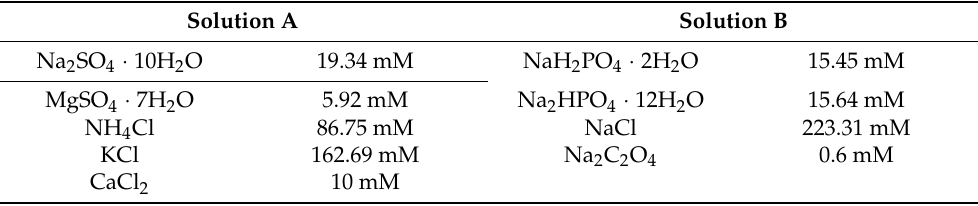
Table 1. Composition of synthetic urine. Synthetic urine was obtained by mixing equal volumes of Solution A and Solution B and was sonicated, and the pH was adjusted to 6.0 before starting